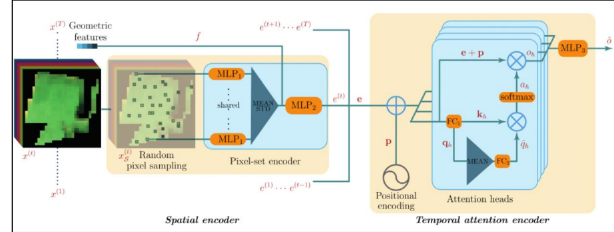
Figure 2. Architecture of the PSE + TAE approach (